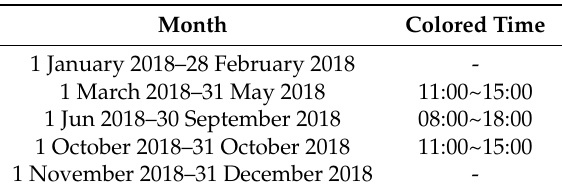
Table 4. ECW colored